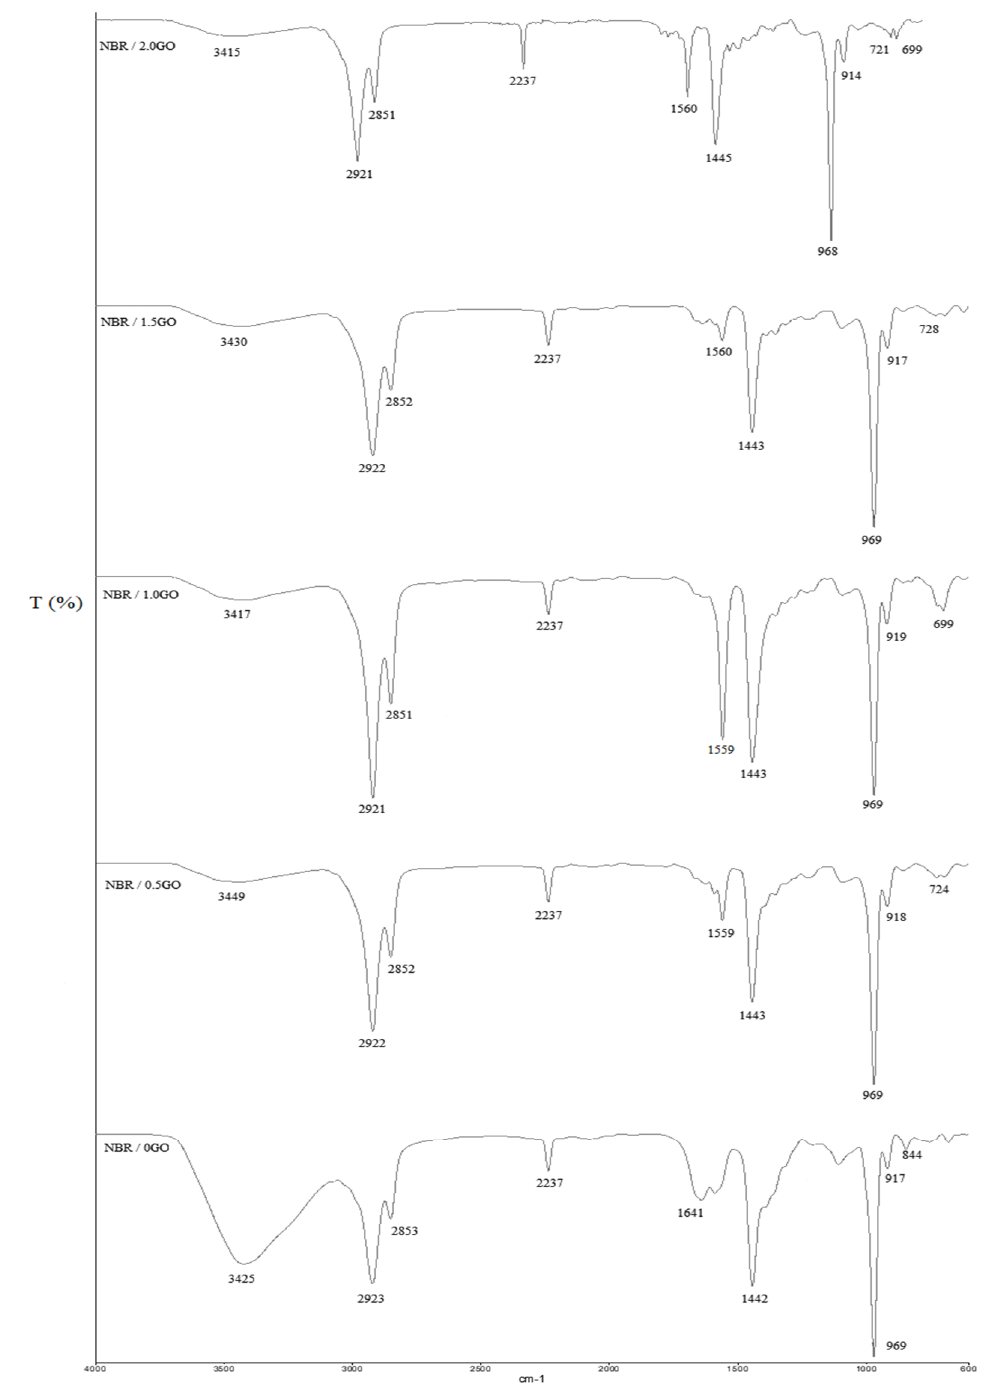
Figure 2. FTIR spectra for pure NBR and NBR-GO membranes at different GO loadings. The peak at 3400 cm − 1 indicates the existence of the O–H functional group from the surface-bounded H 2 O molecules. The peaks at 2237 cm − 1 , 1641 cm − 1 , and 1559 cm − 1 are apportioned to the C– ––N groups, C=C bonds and N–H bending of NBR, respectively [42]. The peak at 1442 cm − 1 confirms the occurrence of carboxylic acid O-H stretching while C- O bending is denoted by 969 cm − 1 peak [43]. The bands between 917 cm − 1 to 699 cm − 1 specify the occurrence of S–OR and S–S disulphide stretching of sulphur crosslinked